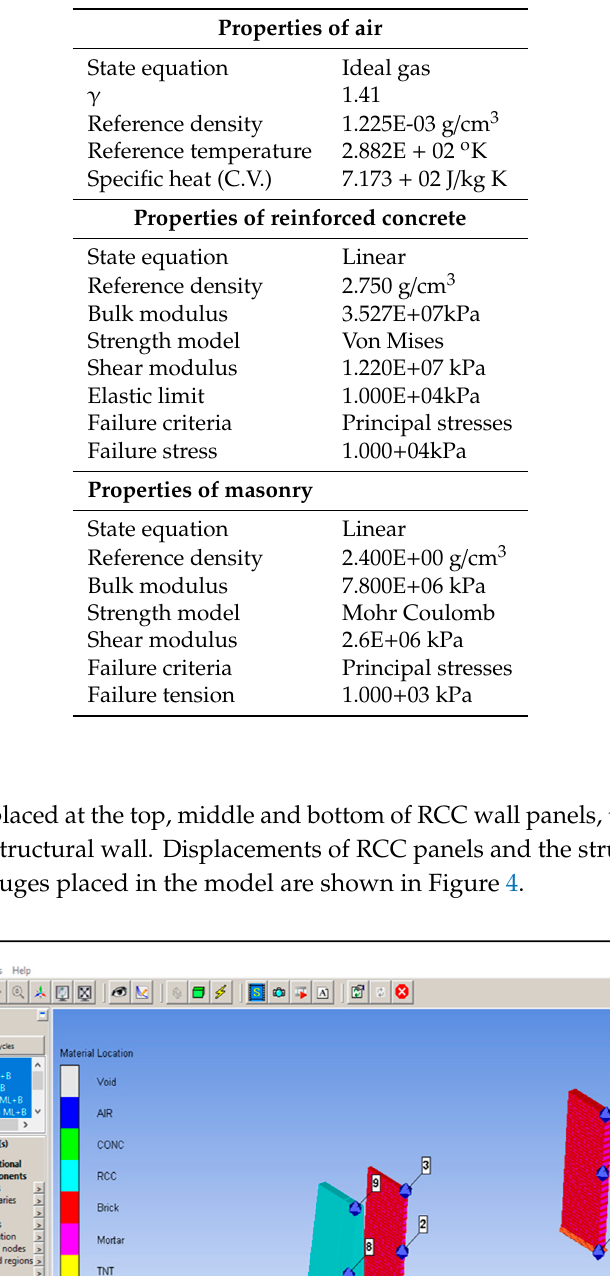
Table 1. Properties of material used in ANSYS AUTODYN.